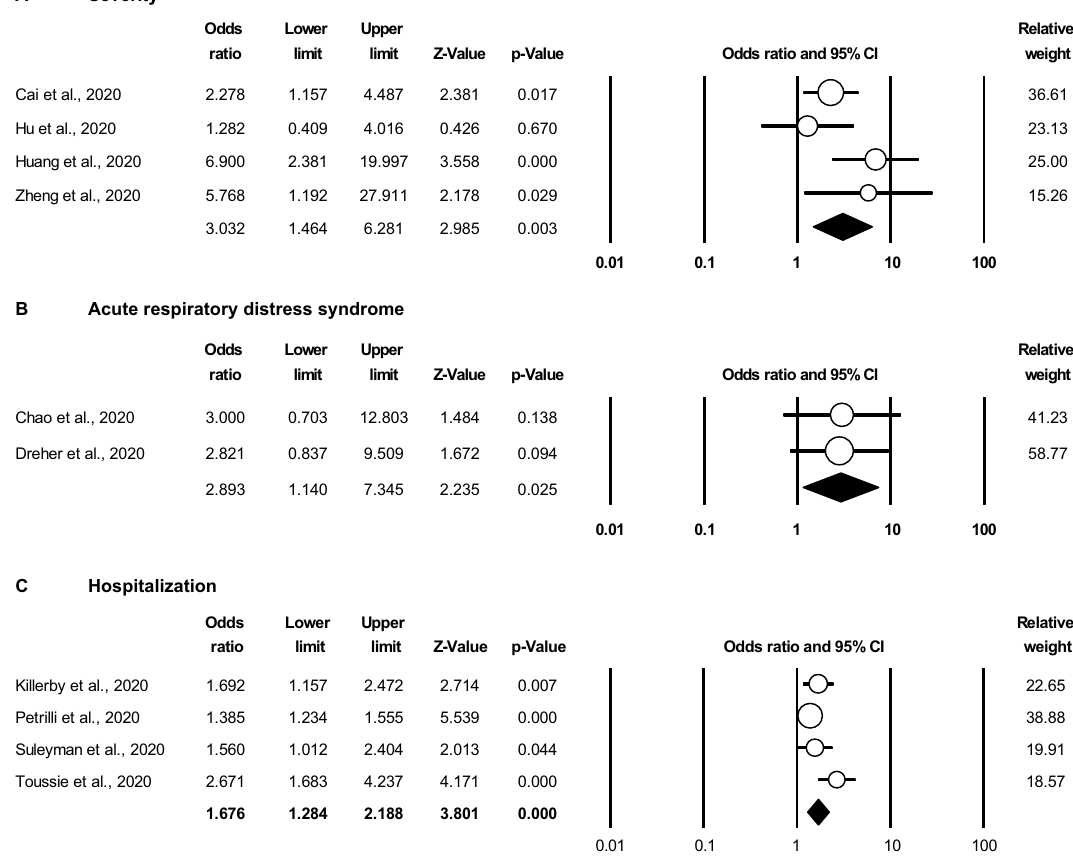
Figure 2. Obesity is associated with more severe COVID-19 and an increased likelihood of acute respiratory distress syndrome (ARDS) and hospitalization. Random effects meta-analyses of odds ratios (OR) and 95% confidence intervals (CI) in obese versus non-obese patients for ( A ) presenting with severe COVID-19 disease (4 studies, n = 915 patients), ( B ) developing acute respiratory distress syndrome (ARDS) (2 studies, n = 96 patients), and ( C ) being hospitalized (4 studies, n = 6,252 patients). Non-obese is defined as the reference